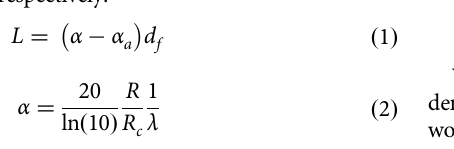
Fig. 1 Acousto-micro fl uidic sensors used to study fl uid – solid slip. a Diagram of the sensor and associated instrumentation. The sensor is composed of an emitter and a receiver spaced by a delay line. As the surface acoustic wave (SAW) travels a distance d f in contact with a fl uid fl ow at a fl ow rate Q , its amplitude is damped. The fl ow at the delay line is parallel to the SAW propagation direction. The emitter and receiver are placed in air cavities to reduce damping from the PDMS. The emitter is a single-phase uni-directional transducer (SPUDT) and the receiver is a standard interdigitated transducer (IDT). Both have the same fi nger pitch, λ , and aperture, A . b Optical micrograph of one sensor ( M fi lled with 1 ). The air cavities around the emitter and the receiver, and the microchannel water are visible. c Optical image of an assembled sensor array located on one micro fl uidic channel. Fluid is con fi ned between a PDMS micro fl uidic channel and the lithium niobate (LiNbO 3 ) substrate. d Sensor array. There are ten sensors M 1 to M 5 and N 1 to N 5 with different d f and λ . The fl uid fl ows from M 1 to M 5 in direction D 1 , and from M 5 to M 1 in direction D 2 . e Calculated local viscous pressure, Δ P/ η , along D 1 . Δ P is the pressure drop between the sensor and the atmospheric pressure at the end of the output tubing. Δ P/ η for different fl ow rates Q , in μ L/min, is represented for M 1 to M 5 , and for the fl ow along the direction D Δ P/ η along D Δ P/ η for different fl ow rates Q , in μ L/min, is represented for M M fl ow along the direction D 1 . f 2 . 1 to 5 for the 2 length 27,28 when either fl uid or air is in the micro fl uidic channel is described by α and α a , respectively.